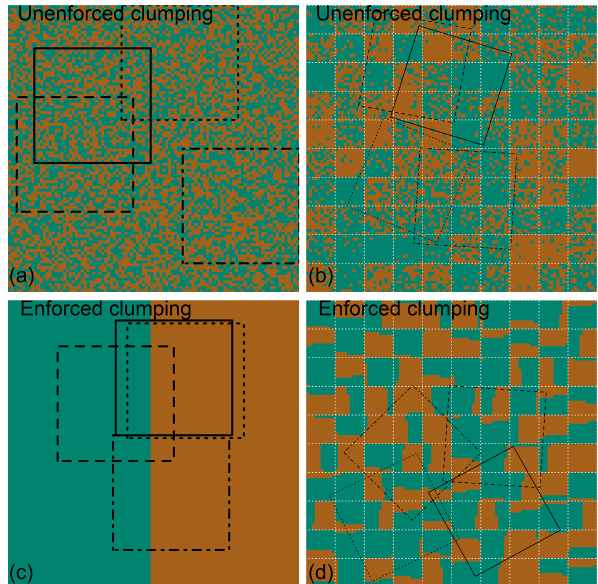
Figure 3. (a, c) Example of the effects of unenforced and enforced clumping in a 250m × 250m MODIS VCF pixel with 50% tree cover. Clumping all the cover (green) to one side of the pixel (c) affects the average canopy cover value of a 100m × 100m sized TROBIT site (black boxes). (b, d) Example of the effects of unen- forced and enforced clumping on 30m × 30m Landsat TCC pixels with a mix of tree cover (green) and non-tree cover (brown). White dotted lines are TCC pixel boundaries. Clumping all the cover to one side of the pixel (d) affects the average canopy cover value of a 100m × 100m sized TROBIT site (black